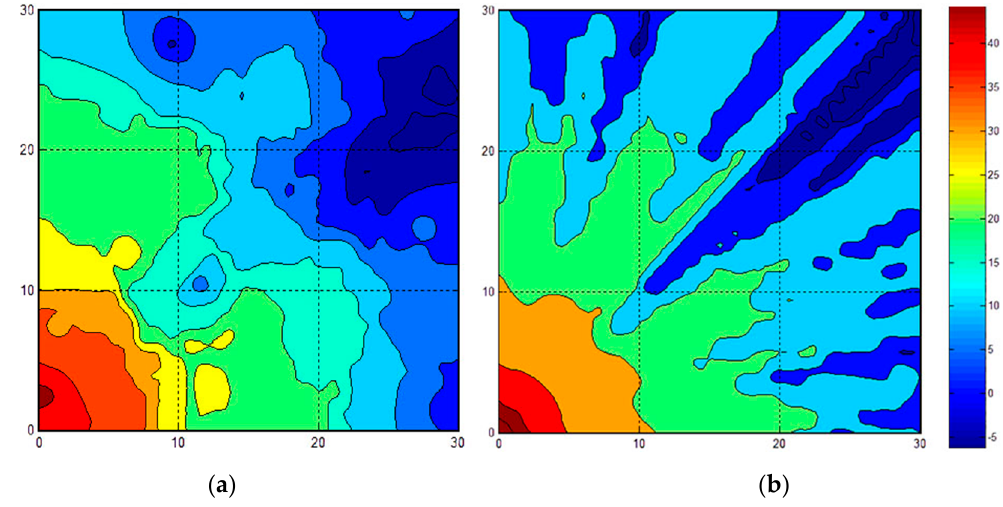
Figure 6. WAF = 6.4 with 30 feedbacks. ( a ) The strength mapping using our proposed method ( b ) The total resampling result with Equation (1).